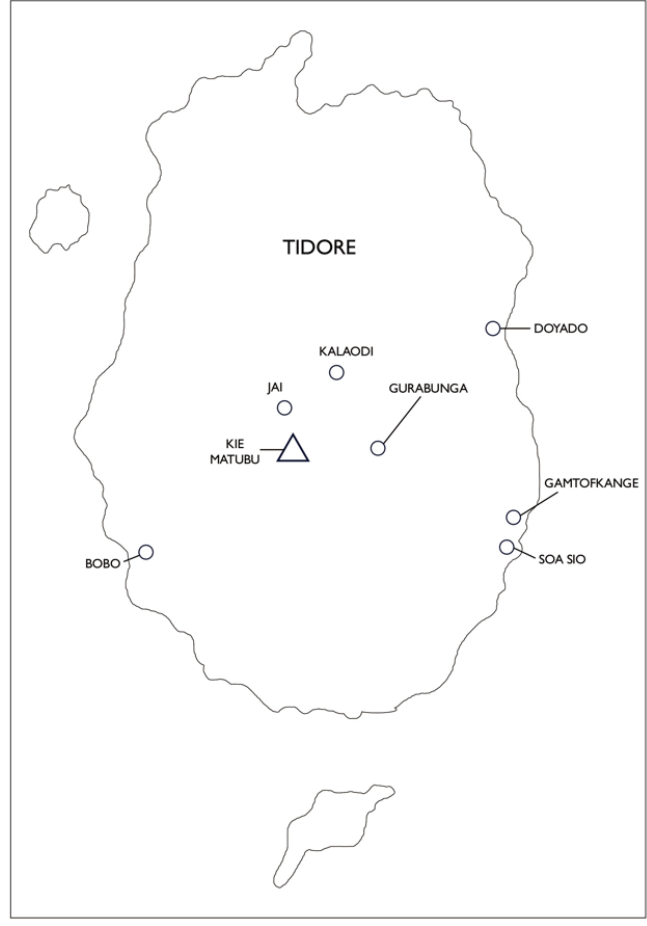
Figure 2. Map of